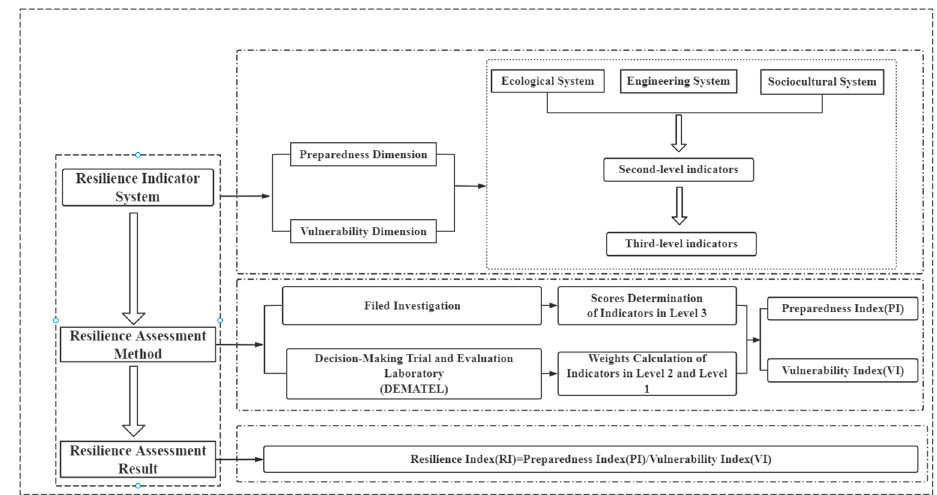
Figure 1. Rural resilient landscape assessment framework.